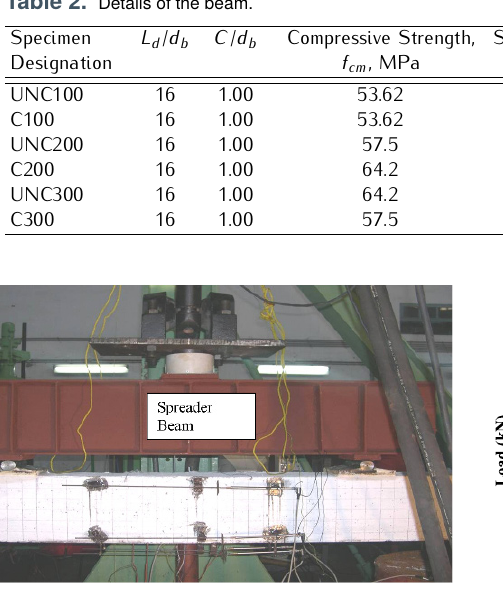
Figure 4. Experimental setup.